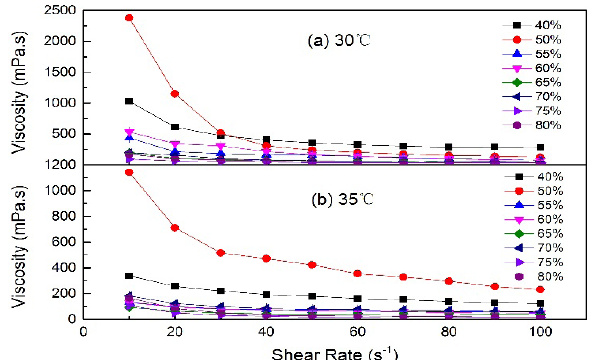
Figure 3: The influence of polymer concentration (708mg/L ) on rheological behaviors at the temperatures (a) 30